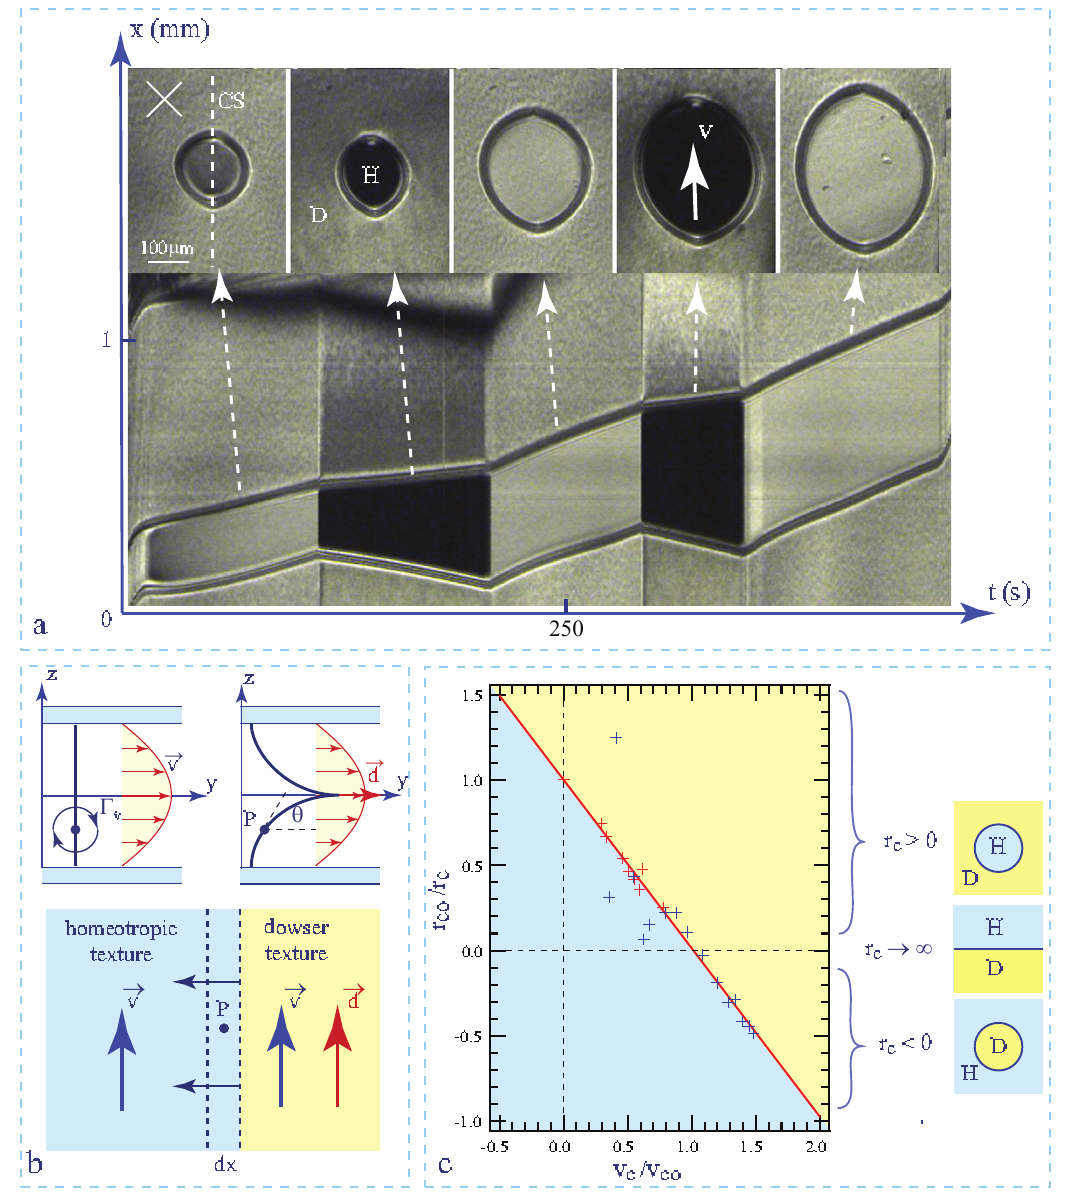
Figure 7. Stability of homeotropic-in-dowser domains in Poiseuille flows. ( a ) Spatio-temporal cross section showing the motion of a homeotropic-in-dowser domain. ( b ) Homeotropic and dowser textures submitted to a Poiseuille flow. ( c ) Stability diagram. Red crosses—experimental points extracted from the spatio-temporal cross sections such as the one in a. Blue crosses—experimental data from Figure 2G in ref. [13]. Red plain line—fit to the Equation (8). (5CB, h = 60 µ m).